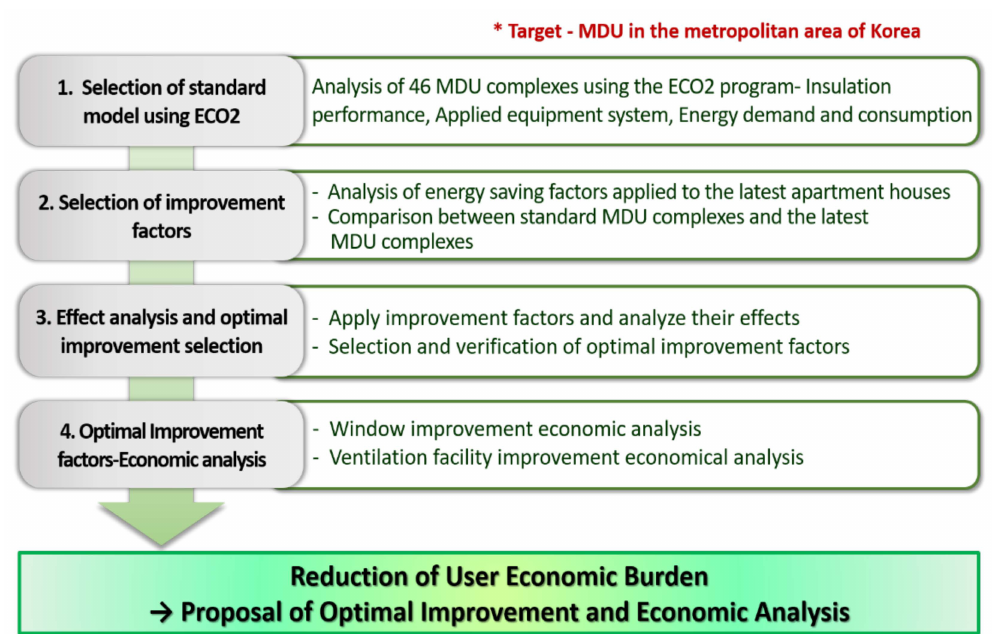
Figure 3. Research methodology: selection of optimal improvement factors and economic analysis of MDUs in metropolitan areas of Korea, using the building energy assessment program